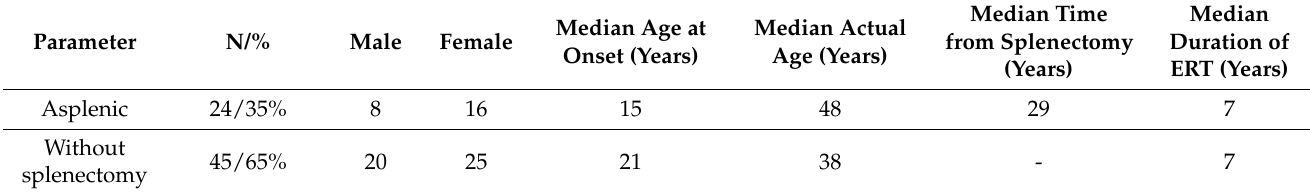
Table 1. Characteristics of patients with Gaucher